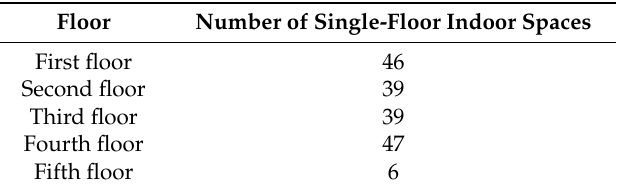
Table 3. Number of single-floor indoor spaces in the experimental data.